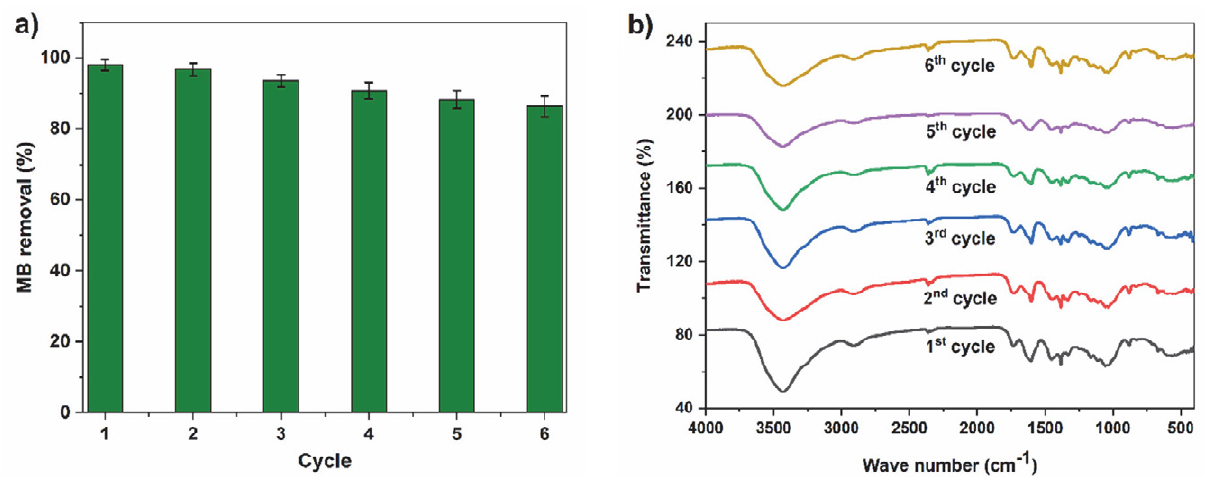
Fig. 12. (a) Removal efficiency of MB onto SA-RPB in successive desorption–adsorption cycles; (b) FTIR spectra of SA-RPB after six desorption–ab- sorption cycles. The tests were done using 1.0 g/L SA-RPB at 150 mg/L MB concentration and 6.5